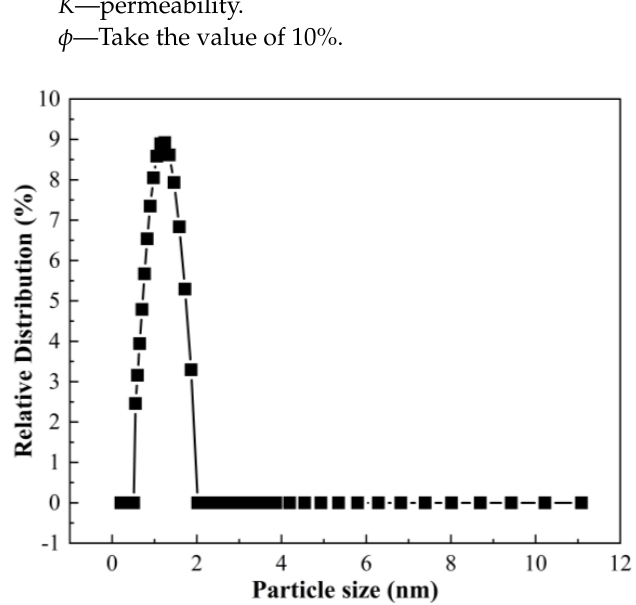
Figure 4. Particle size distribution (intensity) diagram of CQD-W. To ensure that the tracer particles can pass through the formation pore throat smoothly, the radius of the tracer microspheres should be no larger than the hydrodynamic radius of the pore throat. For size 10 nm particles, this generally applies to reservoirs with permeability above 0.005 mD.